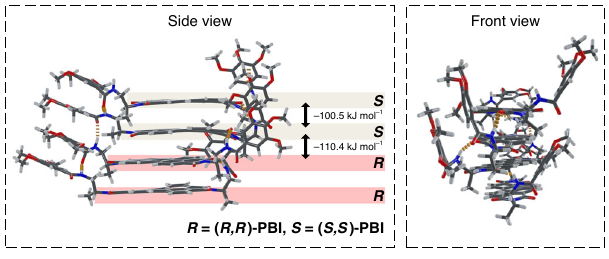
Fig. 3 Quantum chemical calculations. Side and front view of a geometry- optimized tetramer structure extracted from an octameric stack of Rac-Agg 4 (Supplementary Fig. 13). Hydrogen bonds are indicated by orange dashes and dodecyloxy chains have been replaced by methoxy groups.